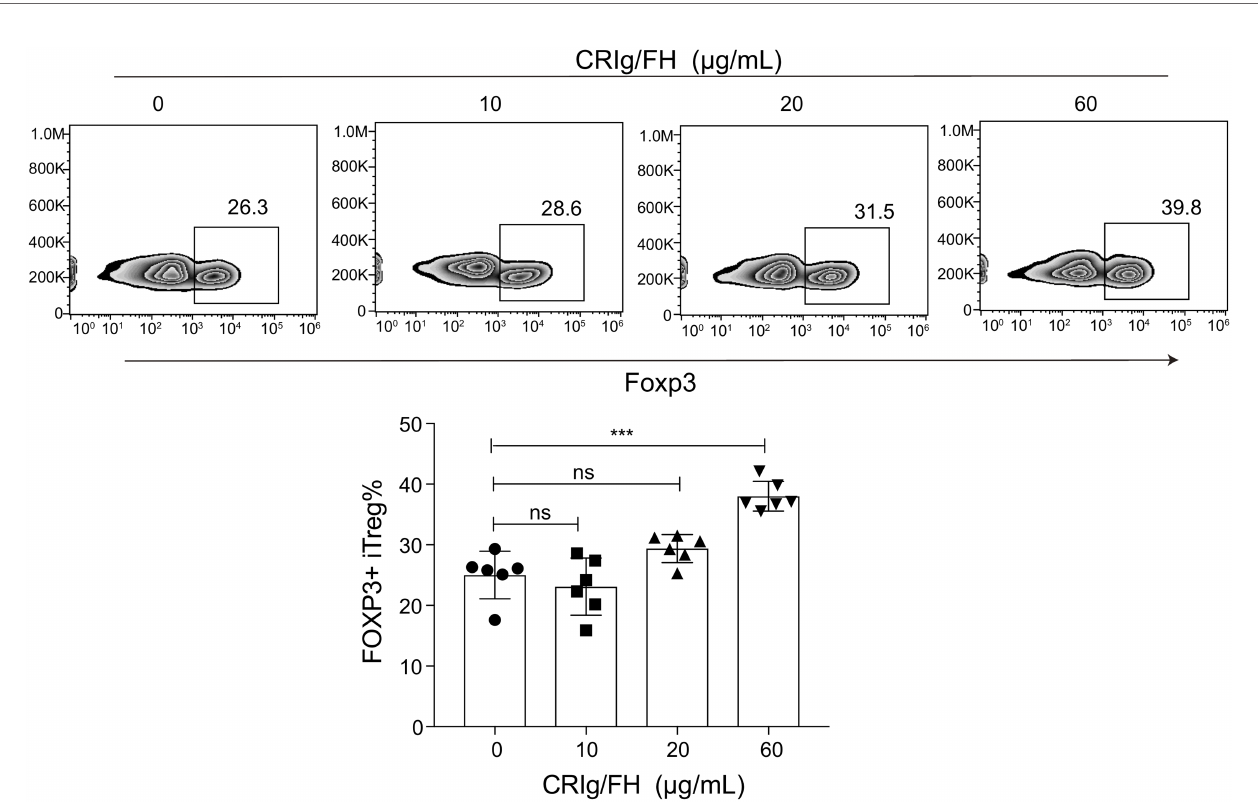
FIGURE 6 | CRIg/FH promotes Treg differentiation in vitro . CD4 + CD25 − conventional T cells were stimulated with immobilized anti-CD3, anti-CD28 antibodies, IL-2, and TGF- b in the absence or presence of the indicated concentrations of CRIg/FH. Foxp3 expression was assessed by fl ow cytometry on day 5 after stimulation. Representative images and quantitative data showed the generation of iTreg cells under various concentrations of CRIg/FH treatment. Results are expressed as means±SD, n = 6/group, and ns, not signi fi cant, *** p <0.001 determined by one-way ANOVA followed by Dunnett ’ s multiple comparison